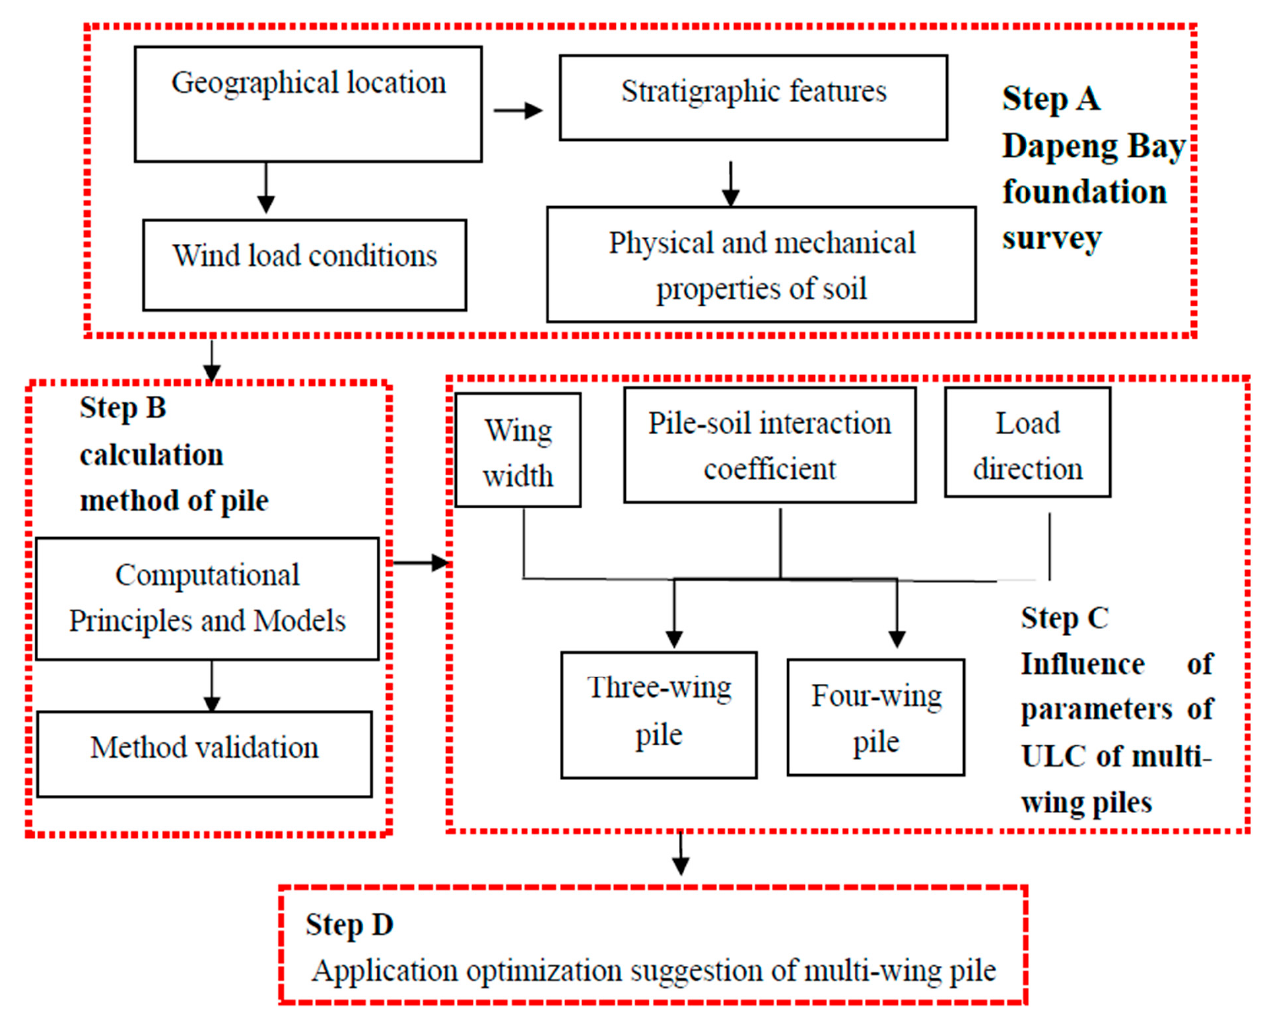
Figure 1. Flowchart for the research processes. Table 1. Physical and mechanical properties of Dapeng Bay soil.